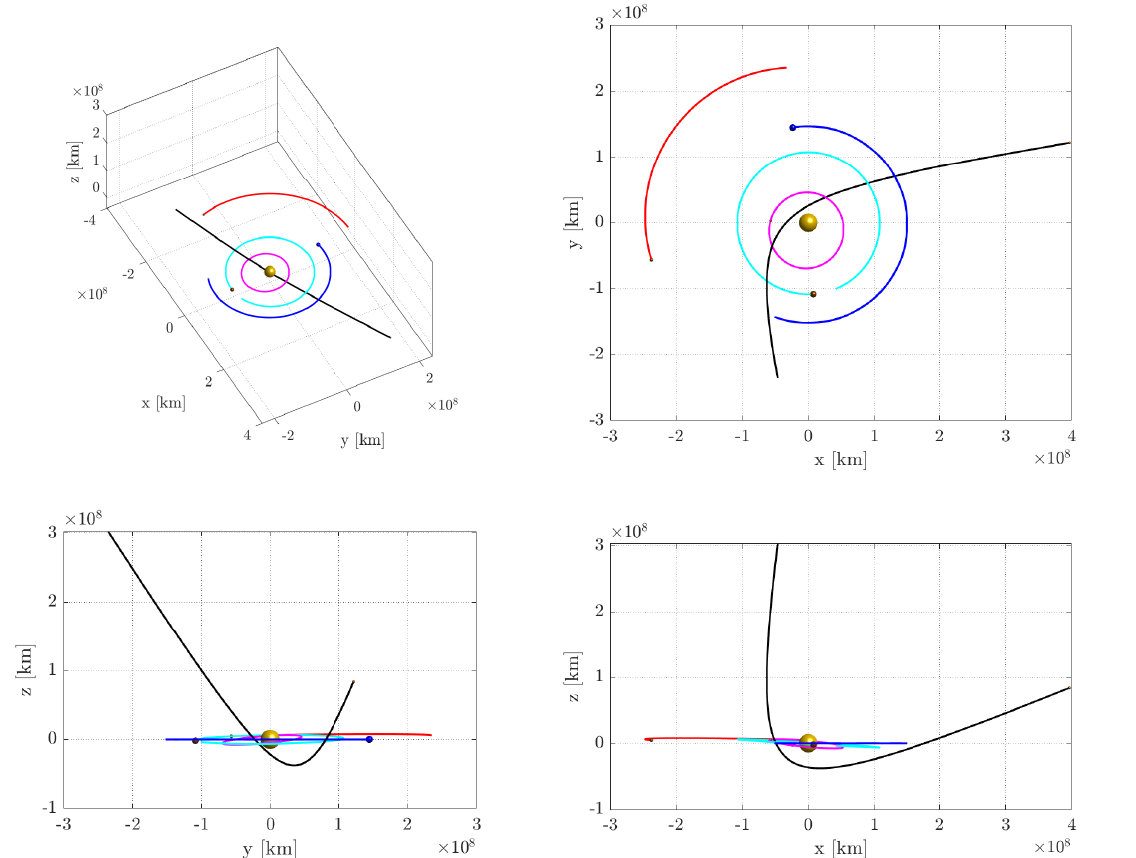
Figure 4. Unperturbed orbit of ’Oumuamua, in km, obtained by the tool (black). The orbits of Mercury (pink), Venus (light blue), Earth (dark blue) and Mars (red) provided by HORIZONS [31] (Courtesy NASA/JPL-Caltech) for the window 1 June 2017–31 December 2017 are also